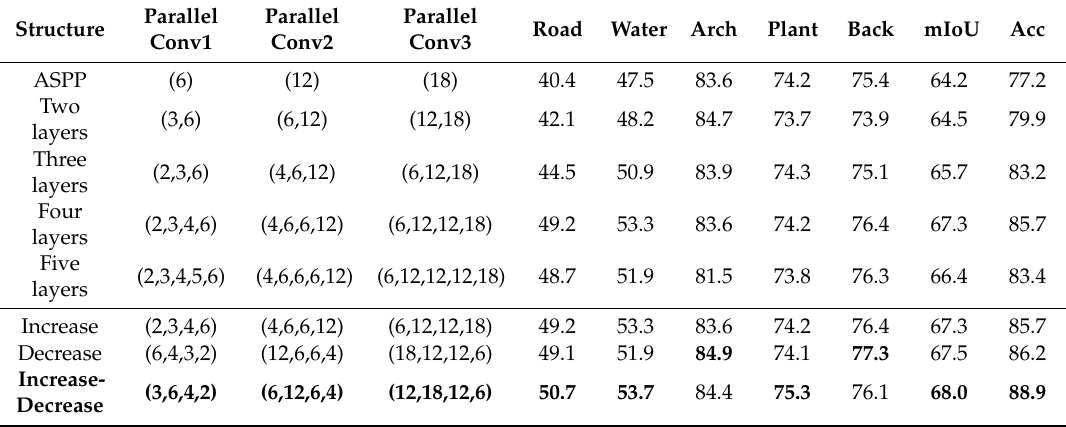
Table 1. Employing di ff erent parameter method for A-ASPP with di ff erent number of layers at output stride = 16. The best model performance is shown in